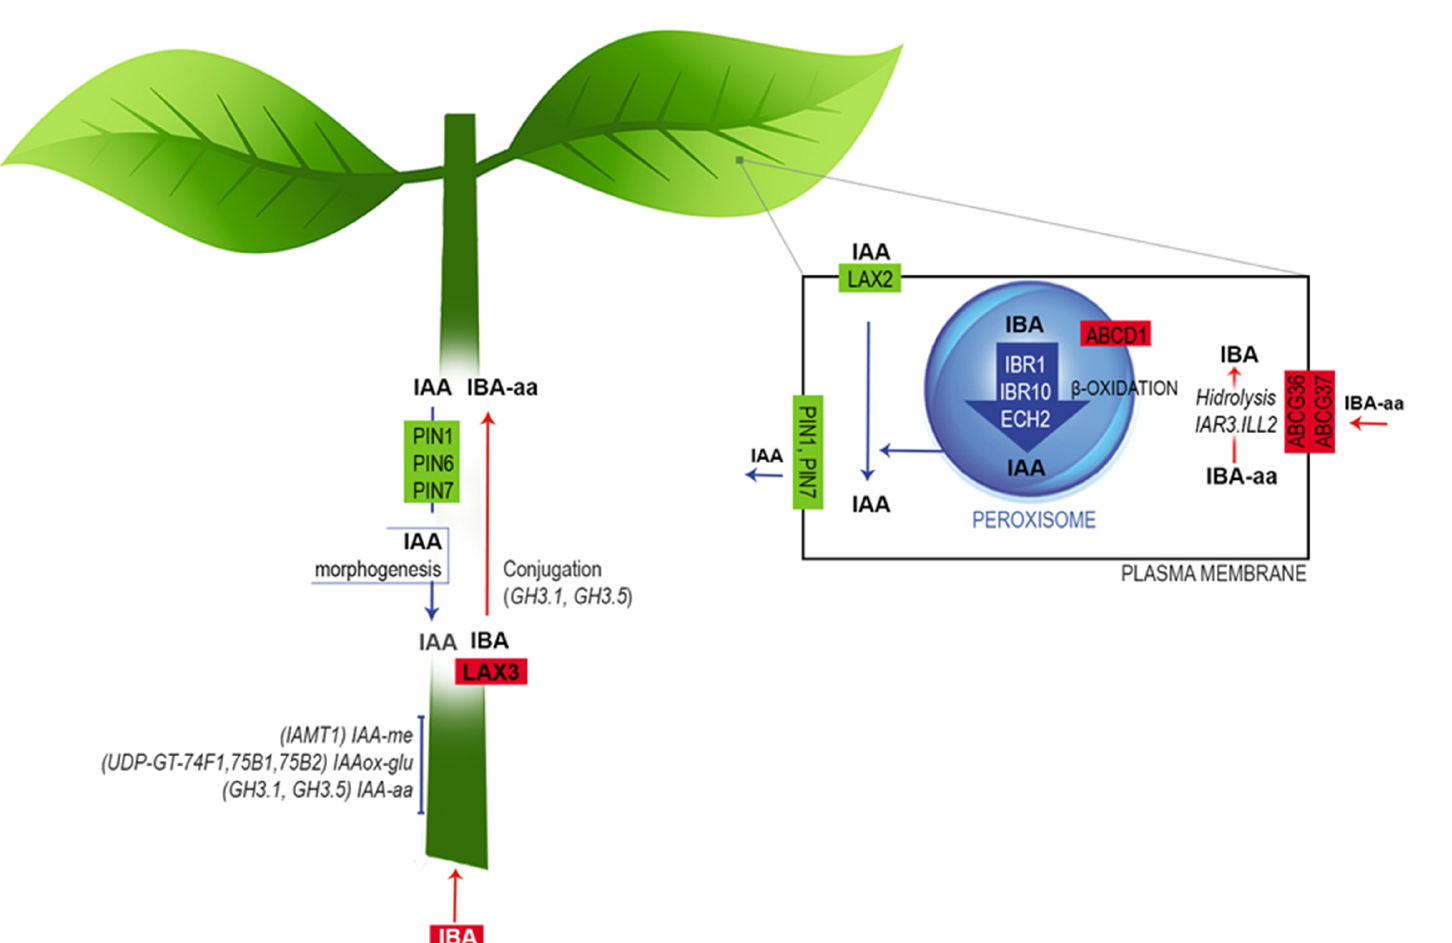
Figure 8. Working model of auxin metabolism during the induction phase of E. nitens adventitious root formation. Based on the transcriptome profiles and an extensive literature review, we propose that the free IBA is absorbed by the stem and conjugated with amino acids by the action of LAX3. Next, as an amide-linked conjugated form, IBA is transported to leaves and converted to IAA through β -oxidation. Finally, IAA is transported basipetally via the phloem to the rooting zone, triggering cell dedifferentiation to form root primordium. Further explanations are provided in the text. The figure is adapted from Frick and Strader [43].